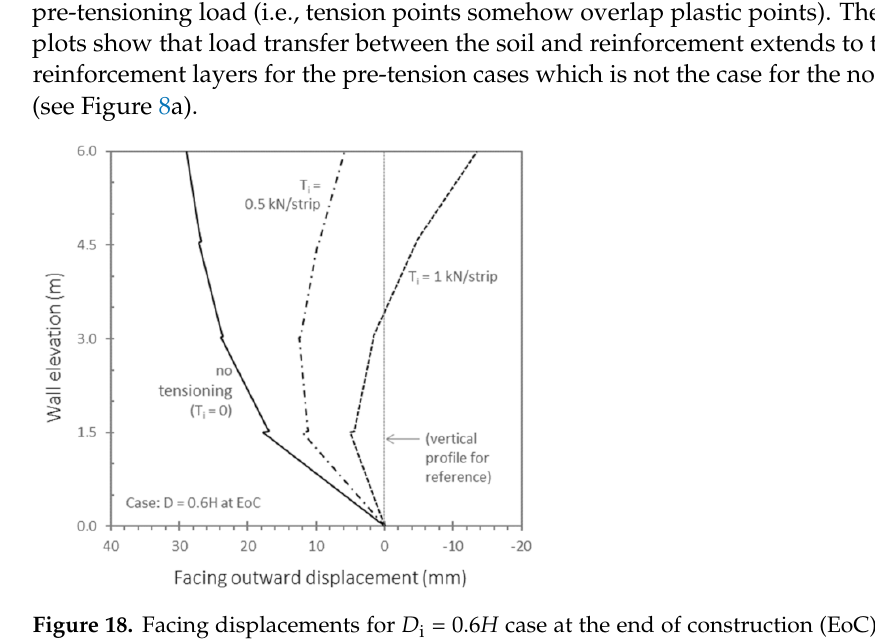
Figure 18. Facing displacements for D i = 0.6 H case at the end of construction (EoC) and different pre-tensioning scenarios. (Modified from [16]).